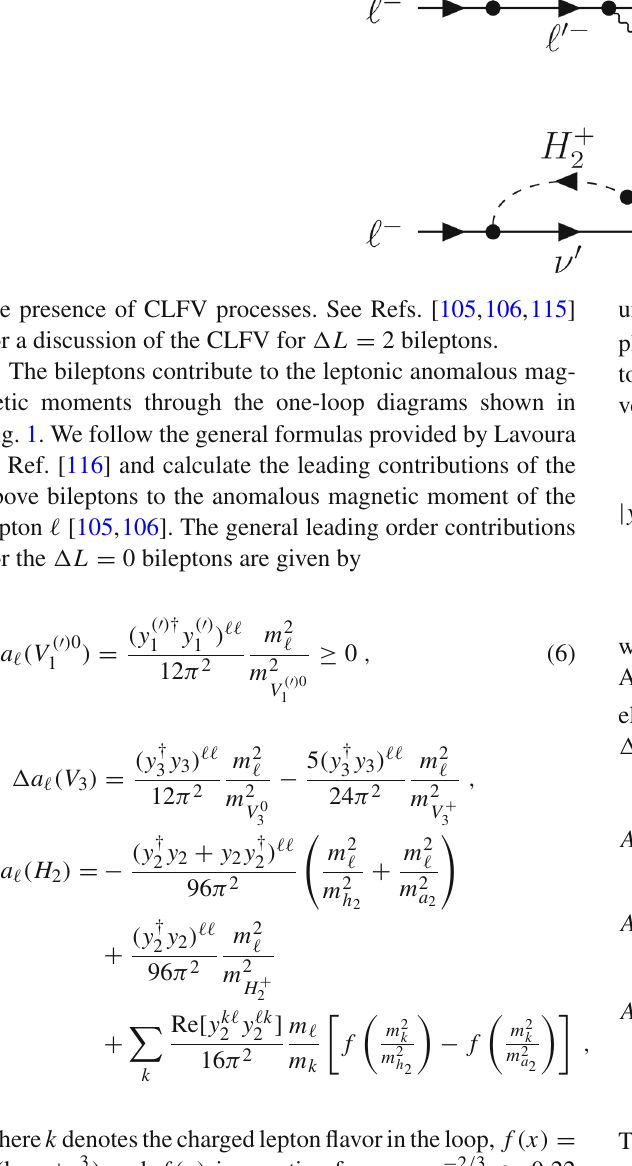
Fig. 1 Diagrams contributing to the leptonic anomalous magnetic moments by the Lagrangian in Eq.